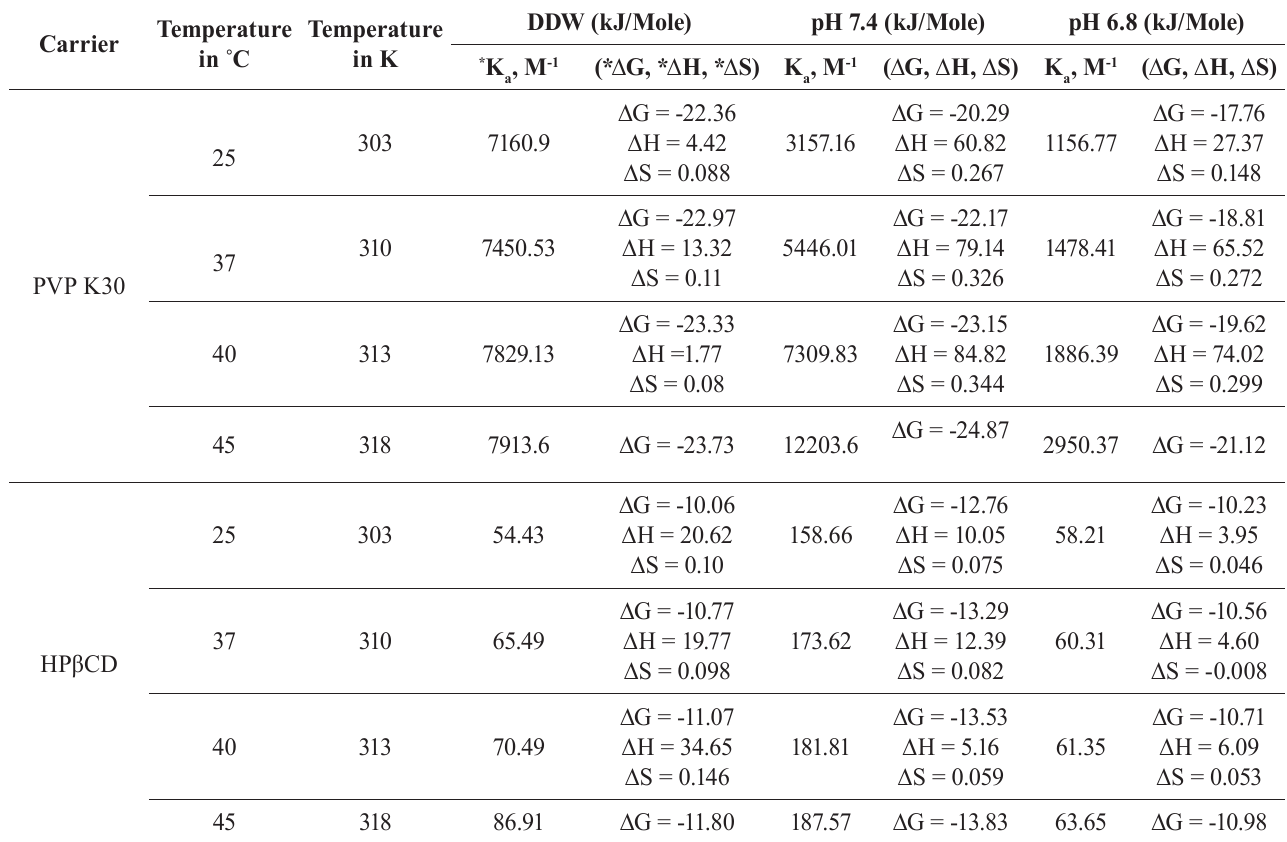
TABLE III - Thermodynamic parameters for the reciprocation of Ondansetron with PVP K30 and HPβCD